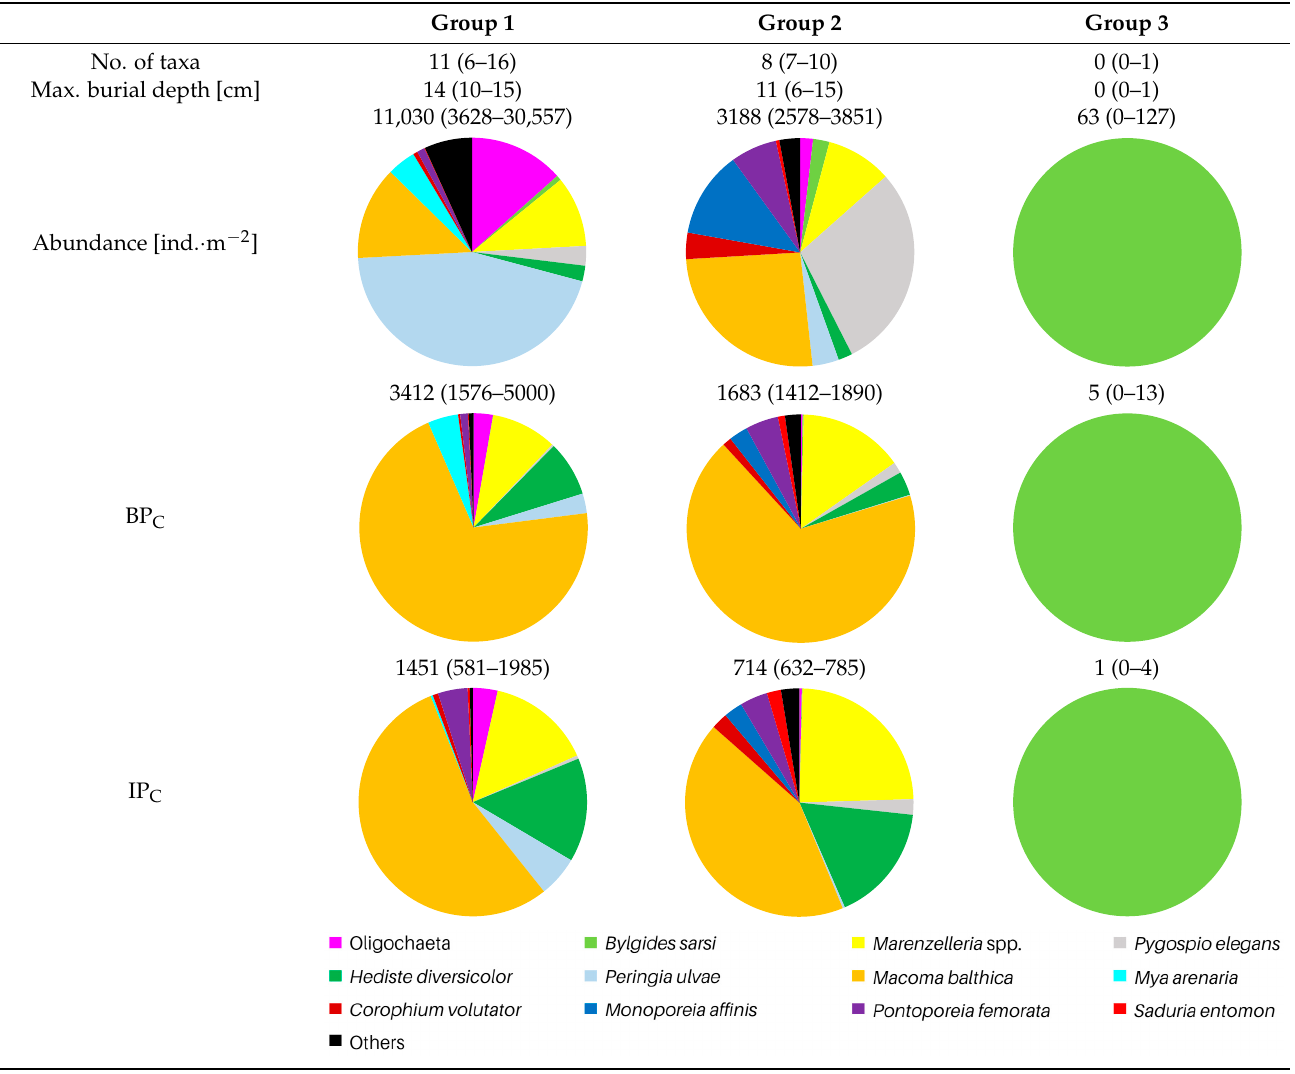
Table 3. Number of taxa, maximum burial depth of macrofauna, mean values: abundance, BP C and IP C (min.–max), contribution of individual taxa to the formation of these parameters, and in each group of sites provided in Figure 3.